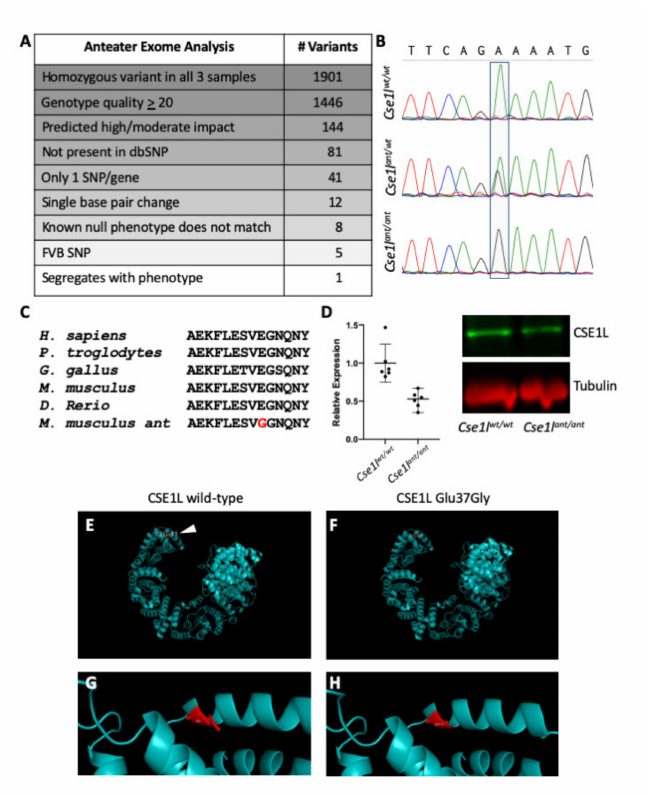
Figure 2. The anteater mutant is an allele of Cse1l. ( A ) Exome filtering revealed Cse1l as a candidate gene for the anteater phenotype. ( B ) Sanger sequence of the anteater allele. ( C ) CSE1L is a highly- conserved protein: the anteater variant is highlighted in red. ( D ) Protein expression was decreased but not absent in Cse1l ant/ant brains; data are graphed as protein expression relative to the wild type (unpaired t test p = 0.0012; line indicates mean value +/ − 95% confidence interval). ( E – H ) Predicted protein structure of CSE1L with the position of the variant amino acid highlighted in